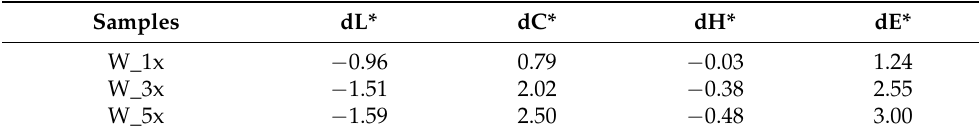
Table 12. Change in color coordinates of the wool sample without mordants after 1st, 3rd and 5th washing cycle (compared with W_0x).